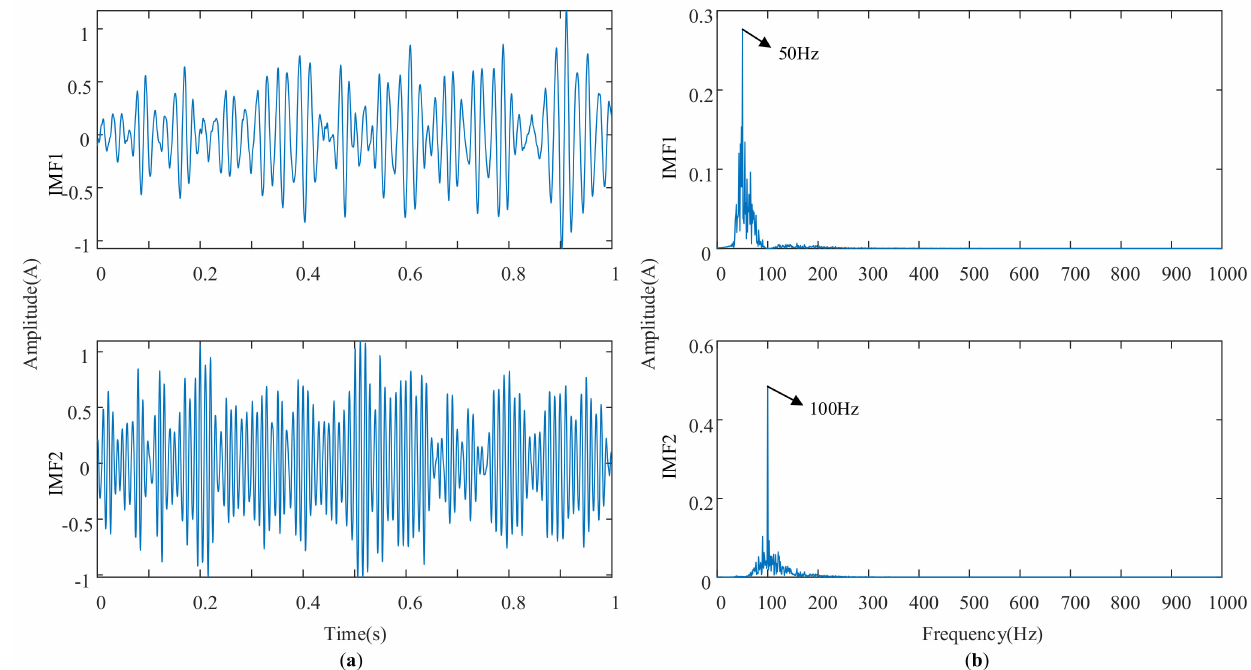
Figure 10. IMF components after VMD decomposition by second ACSRS: ( a ) Time − domain; ( b ) frequency